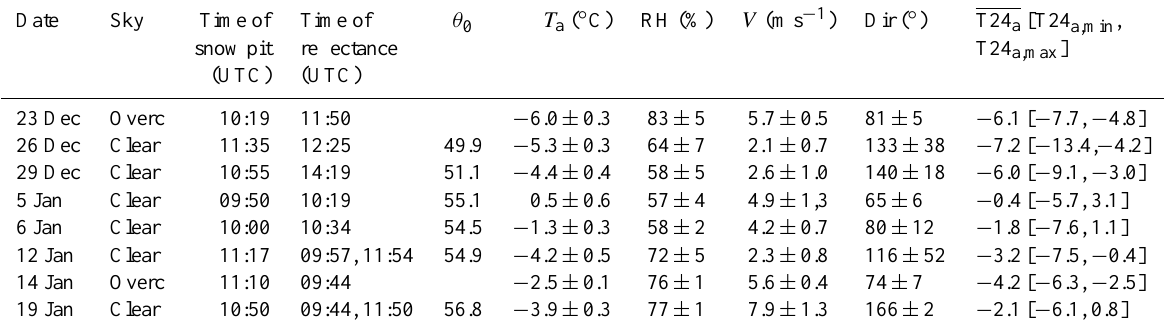
Table 1. Snow pit and spectral reflectance measurement times during clear and overcast days, mean solar zenith angle ( θ 0 ) during the clear-sky reflectance measurements, as well as the mean value and standard deviation of the air temperature ( T a ) , relative humidity (RH), wind speed ( V ) , and wind direction (Dir) during the time frame covered by the snow and reflectance measurements. The last column gives the mean, minimum, and maximum air temperature in the 24h preceding the corresponding snow pit measurements (T24 a , T24 a,min , and T24 a,max , respectively). Local solar time is approximately UTC – 54min.